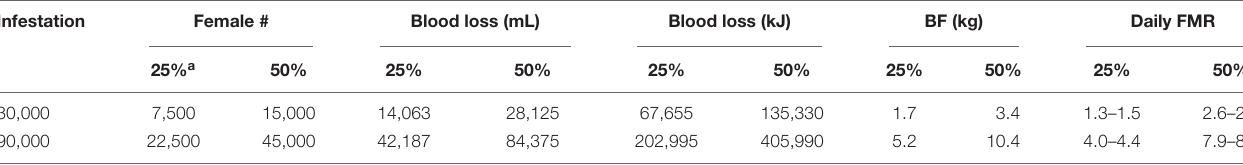
TABLE 2 | Baseline estimates and values used to describe the energy impact from blood loss associated with feeding by adult female winter ticks on pregnant moose. Infestation Female # Blood loss (mL) Blood loss (kJ) BF (kg) Daily